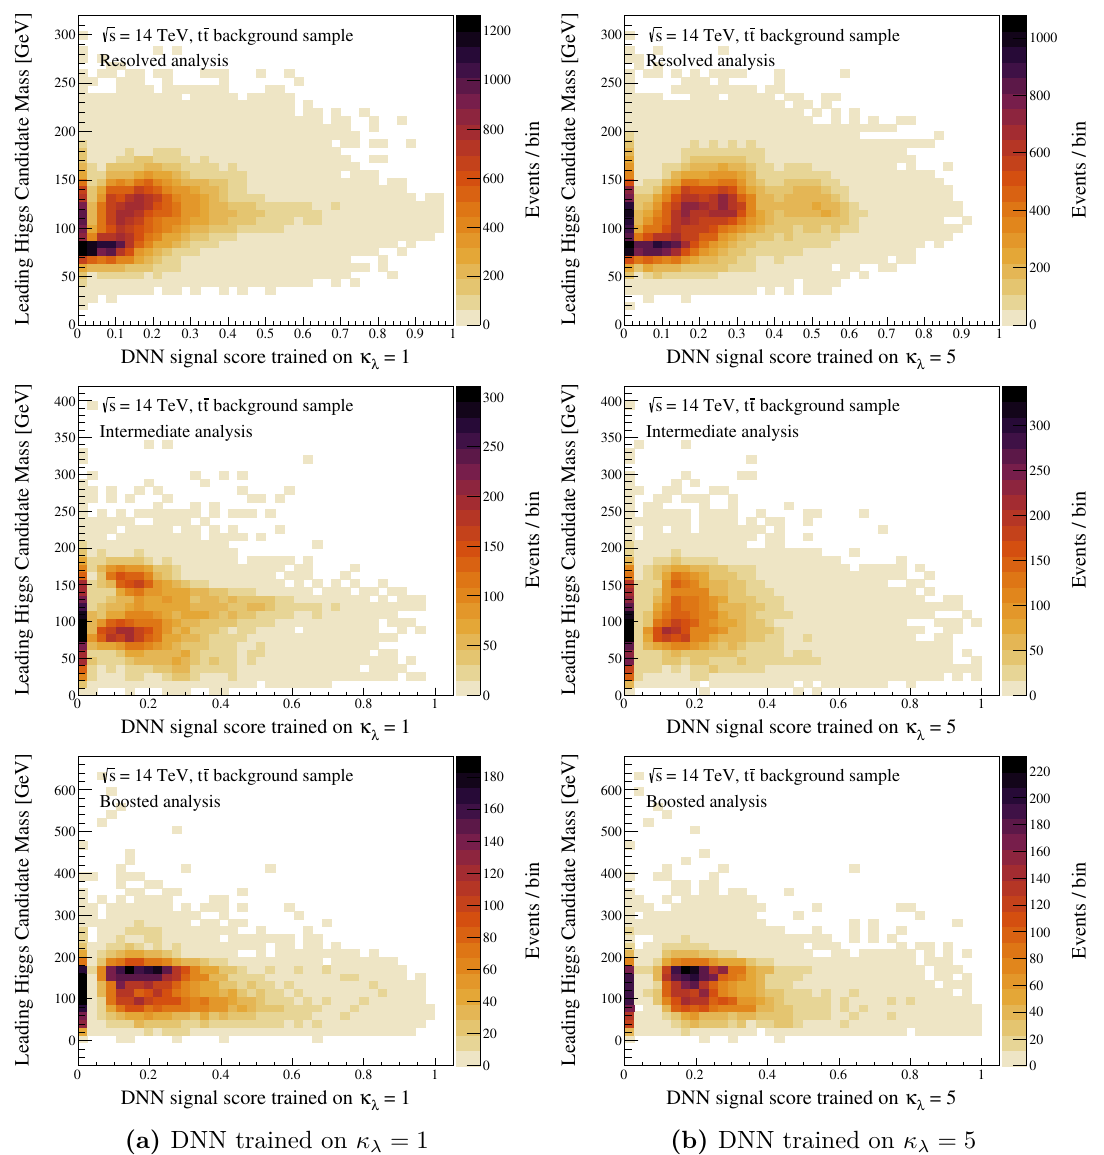
Figure 23. The leading Higgs candidate mass vs neural network scores trained on (a) κ λ = 1 and (b) κ λ = 5 signal sample for the (upper) resolved, (middle) intermediate, and (lower) boosted analyses. The test samples used to make these distributions are an independent set of t ¯ t